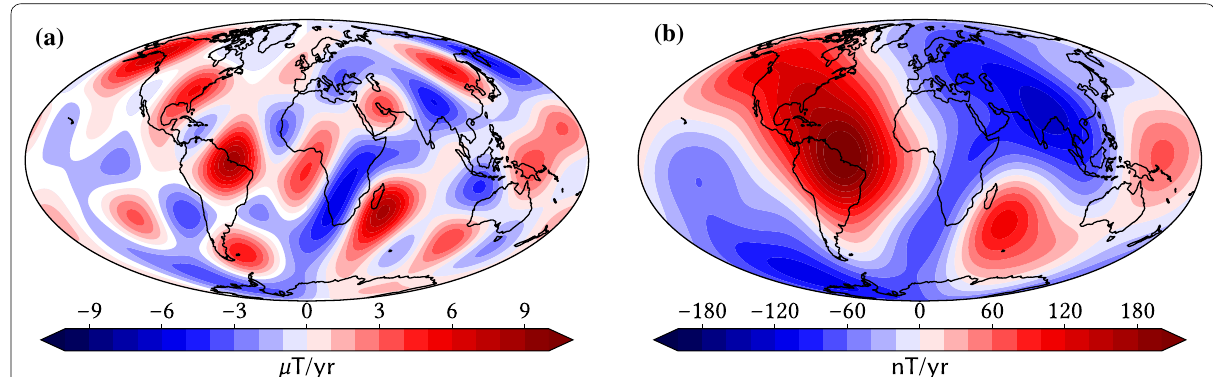
Fig. 5 Radial secular variation of the candidate model (truncated at spherical harmonic degree 8), shown at the core surface ( a ) and at Earth’s surface ( b ). Mollweide projection